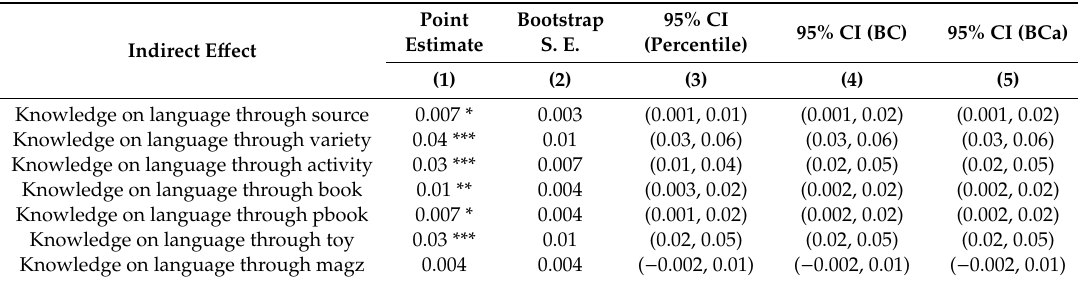
Table 5. Estimates of indirect e ff ects of parenting knowledge on language development through di ff erent parental investments.